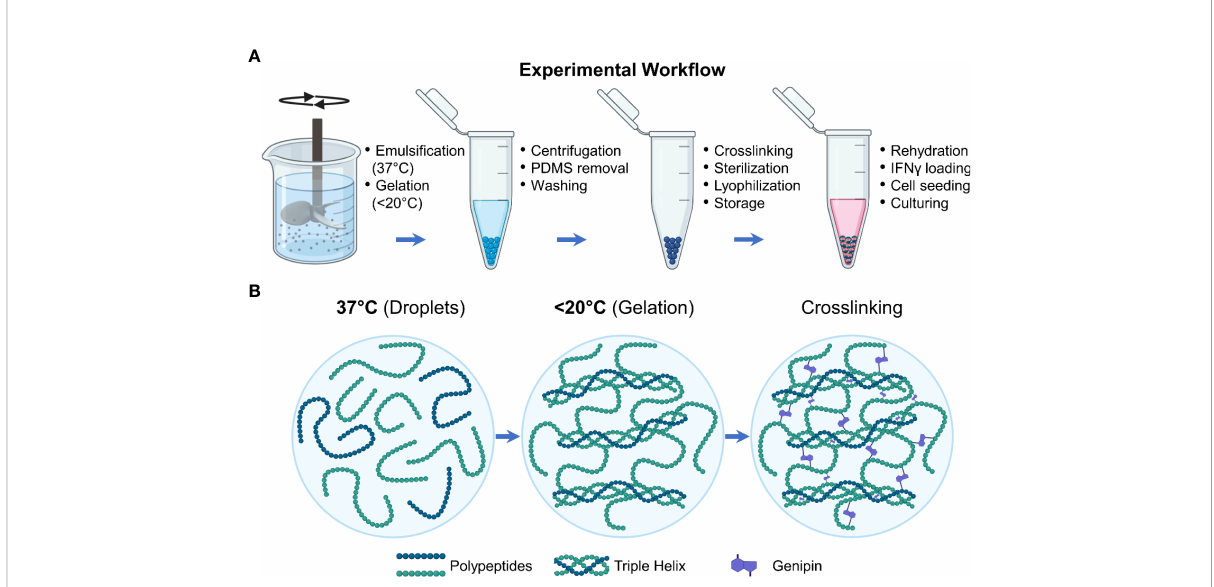
FIGURE 1 Experimental work fl ow. (A) Schematic showing the steps involved in the fabrication and preparation of the licensing microgels. (B) During the fabrication processes, the gelatin polypeptides undergo a temperature-driven structural reorganization which is solidi fi ed through genipin